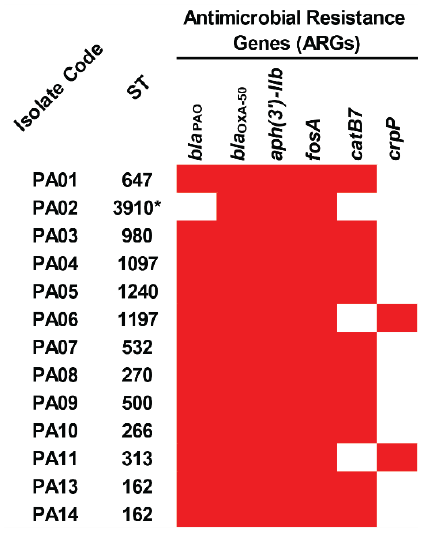
Figure 1. Distribution of antimicrobial resistance genes (ARGs) in the colonizing isolates of P. aeruginosa . The red box represents the gene presence. ST, sequence type. * Novel ST.